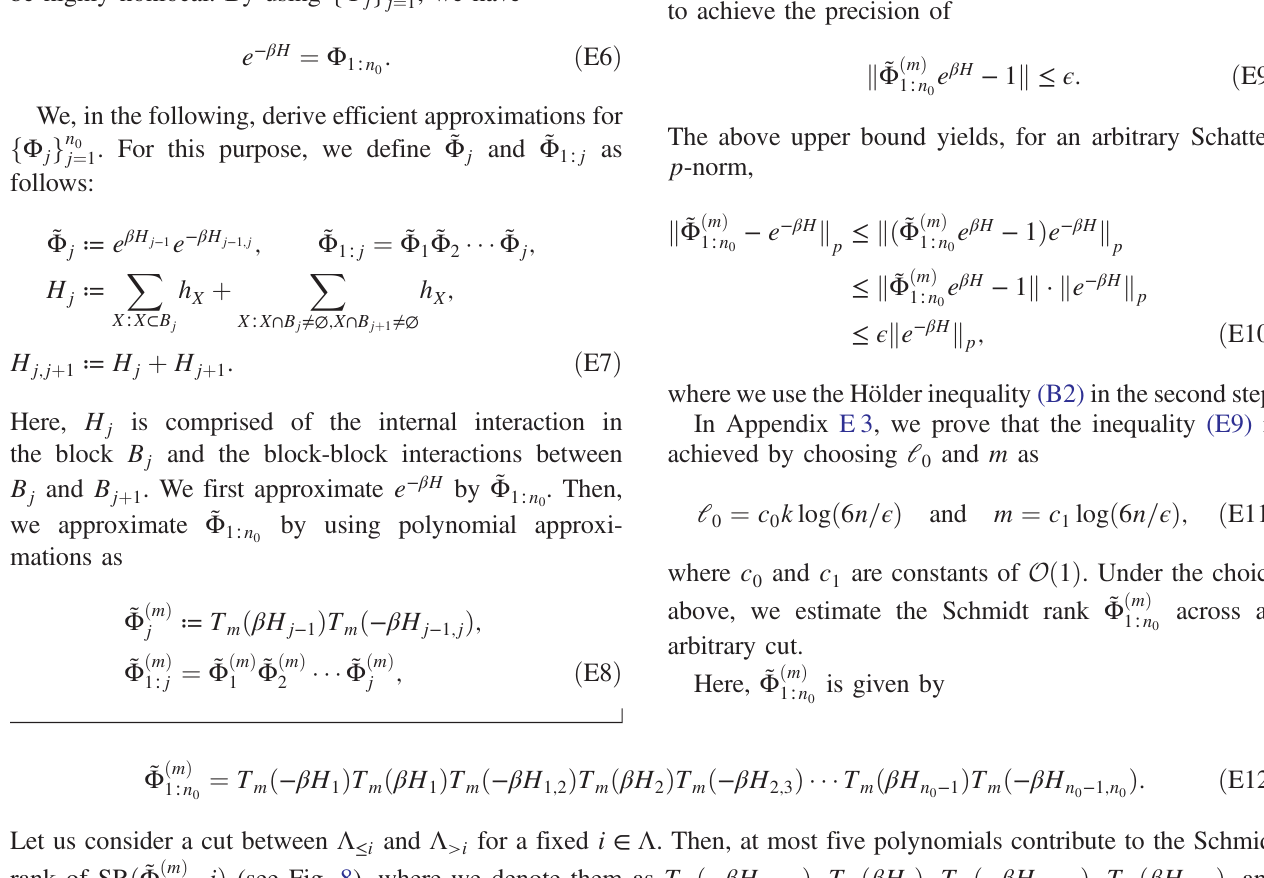
˜ Φ ˜ Φ − β H ≈ ˜ Φ ð m Þ ≈ ˜ Φ ð m Þ 1 ∶ n 0 and (ii) 1 ∶ n 0 1 ∶ n 0 , which yield e 1 ∶ n 0 . Here, the approximated quantum